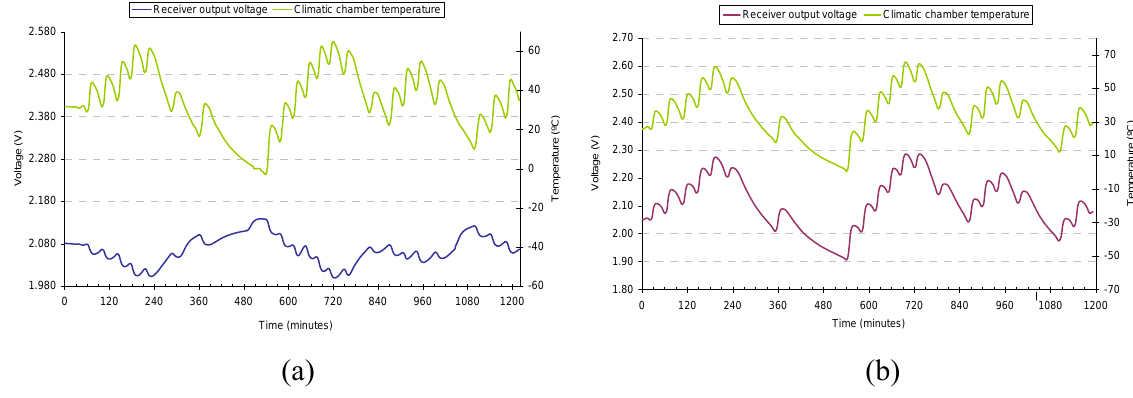
Figure 8. (a) Receiver output voltage in emitter thermal test. (b) Receiver output voltage in receiver thermal